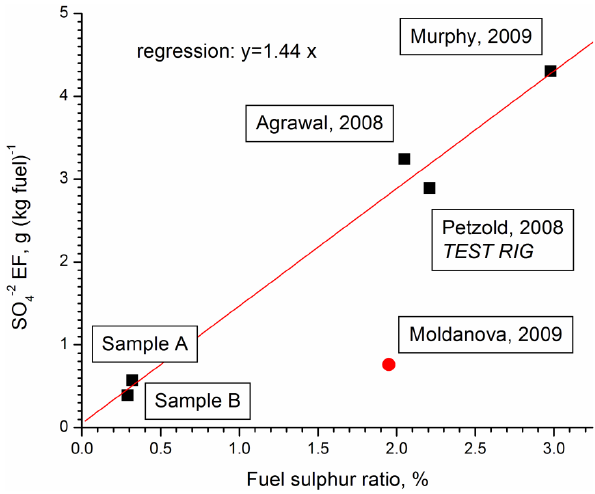
Fig. 14. The SO 4 2 − EF as a function of fuel sulphur ratio. Red dot marks an outlier that was ignored during the regression calculation. Slope of the regression line: 1.44 ± 0.1, intercept forced to be zero, R 2 :